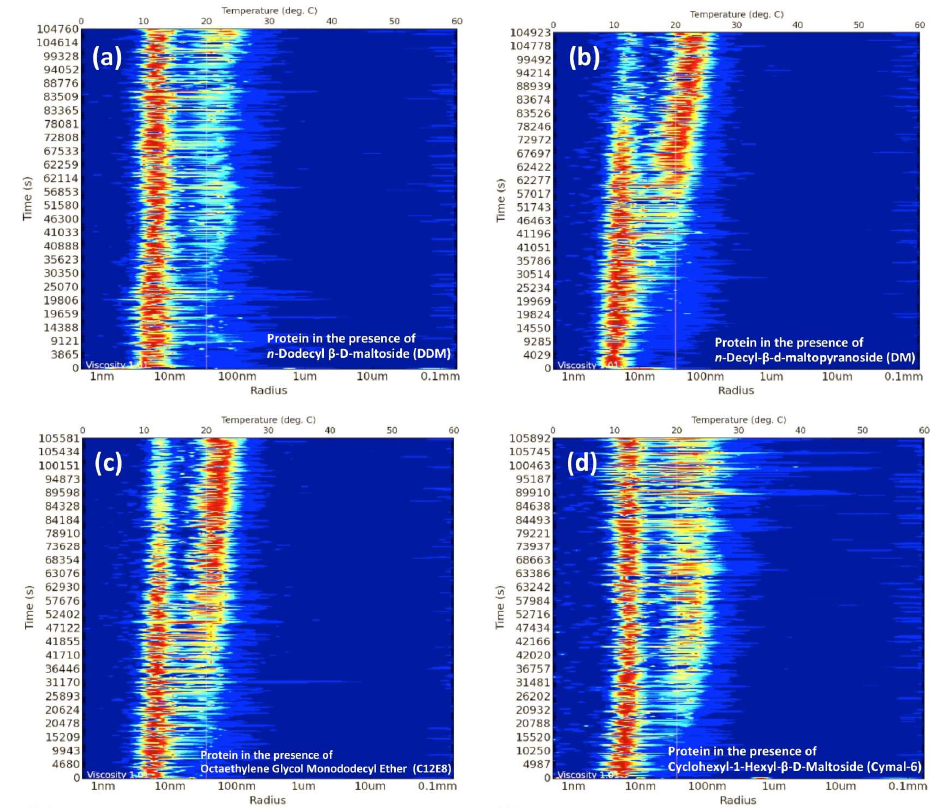
Figure 3. Illustration of a multi-detergent screening experiment assessing protein stability over time. Each panel corresponds to the same protein (a membrane protein transporter) in the presence of different detergents over a period of around 29 hrs. The size distribution plots are in form of signal heat maps (blue = low particle concentration, red = high particle concentration). The in situ DLS radius distribution panels clearly show the appearance of protein aggregates at different rate for each different detergent. The most stable sample is shown in panel ( a ). Here, the protein in the presence of n-Dodecyl β- D -maltoside (DDM) detergent takes a longer time to form larger particles (nucleation) that leads to crystal formation after 3 days. Panel ( b – d ) shows that the protein in the presence of those detergents starts forming large aggregates in less than 24 h, in fact the protein does not crystallise when purified in these detergents. The in situ DLS experiments were carried out at 293 K using a SpectroLight 610 (XtalConcepts GmbH, Hamburg, Germany) instrument. 2 μL of each sample were pipetted onto a 72-well Terasaki plate and covered with paraffin oil. The experiments ran according to the hardware specifications of the instrument. The protein was 10× diluted in each buffer (20 mM Tris, pH 7.5, 150 mM NaCl plus 3x critical micelle concentration (CMC) of each detergent) and left to equilibrate for 1 h. Following this, samples were centrifuged at 14,000× g for 20 min at 4 °C.